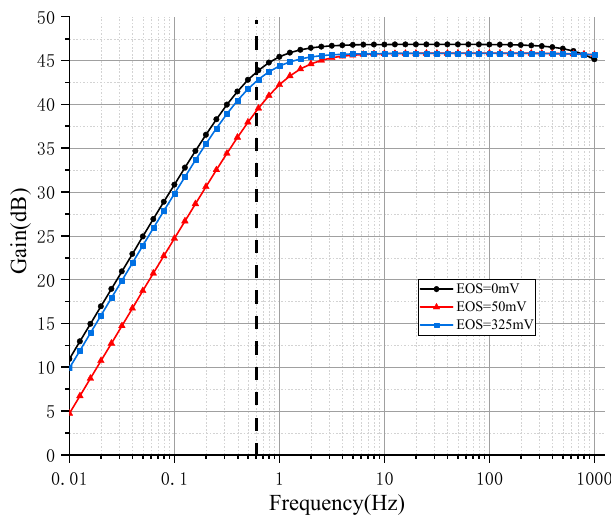
Figure 13. The AC frequency response of the ECG amplifier at different electrode offset (EOS).